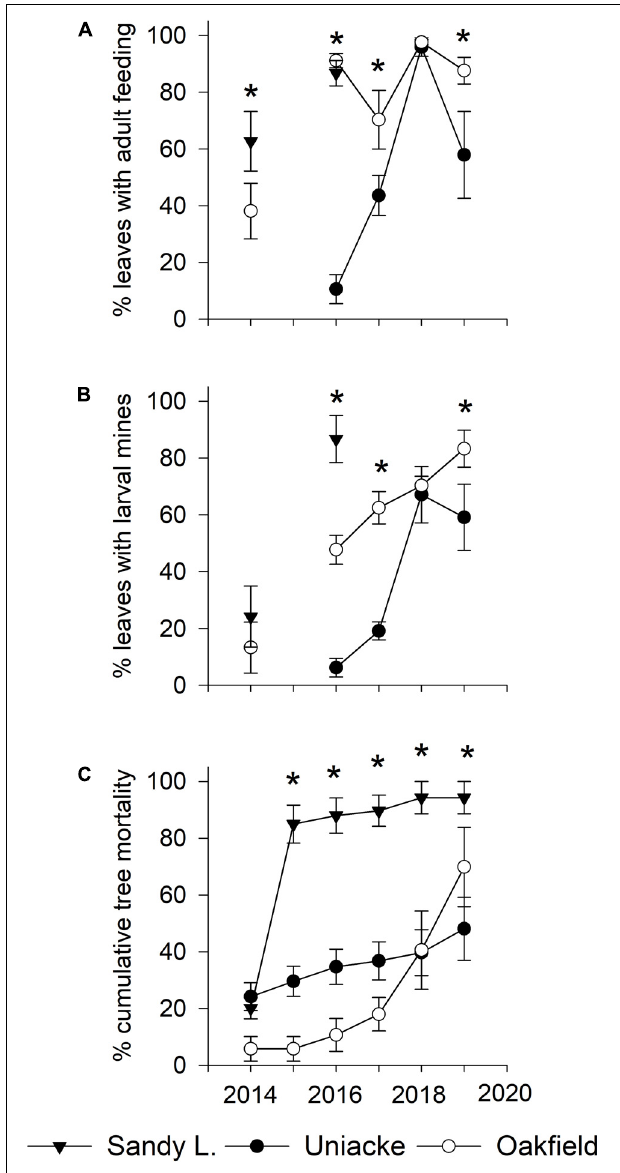
FIGURE 3 | Average ( ± SE) values for: (A) percentage of leaves with Orchestes fagi adult feeding damage; (B) percentage of leaves with larval mines of O. fagi ; and (C) percentage mortality of American beech trees ( ≥ 6 cm diameter at breast height) from 2014 to 2019 in five 11.28 m radius plots at each of three sites (Sandy Lake, Oakfield, Mount Uniacke) in Nova Scotia, Canada. Quantitative estimates of leaf damage were not made at Mount Uniacke in 2014 because visual surveys found no evidence of weevil damage. No estimates of leaf damage were made at any site in 2015 due to logistical constraints. Asterisks denote significant differences in mean values among sites within year (generalized linear models on binomial data, P < 0.05, see Supplementary Material Table S1 for F, df , and P